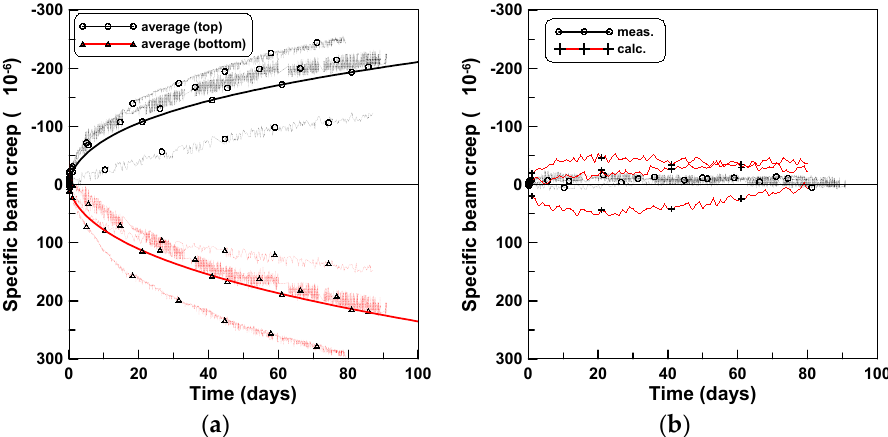
Figure 10. Averaging bending creep strains of TP-1, TP-2, and TP-3: ( a ) top and bottom and ( b ) middle.